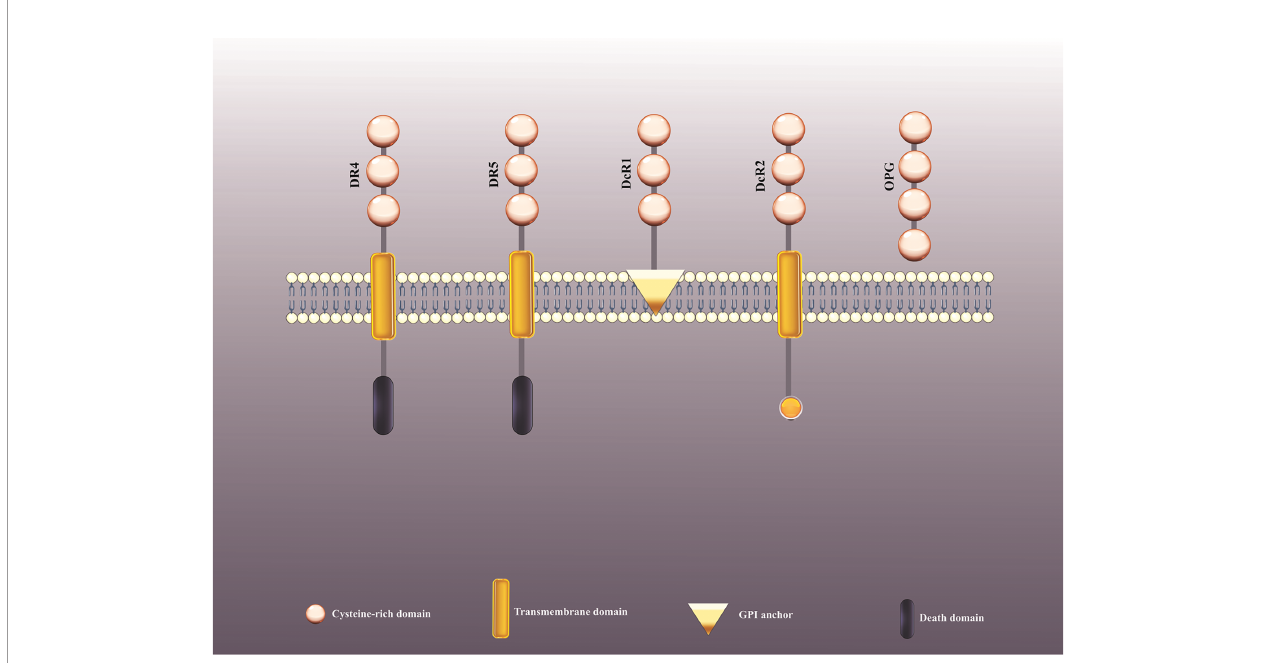
FIGURE 1 | The recognized receptors for TRAIL. TRAIL connects with two agonistic receptors, termed TRAIL-R1 (DR4) and TRAIL-R2 (DR5), and three antagonistic receptors, termed TRAIL-R3 (DcR1), TRAIL-R4 (DcR2) as well as a soluble receptor, known as osteoprotegerin (OPG). TRAIL, Tumor necrosis factor-related apoptosis inducing